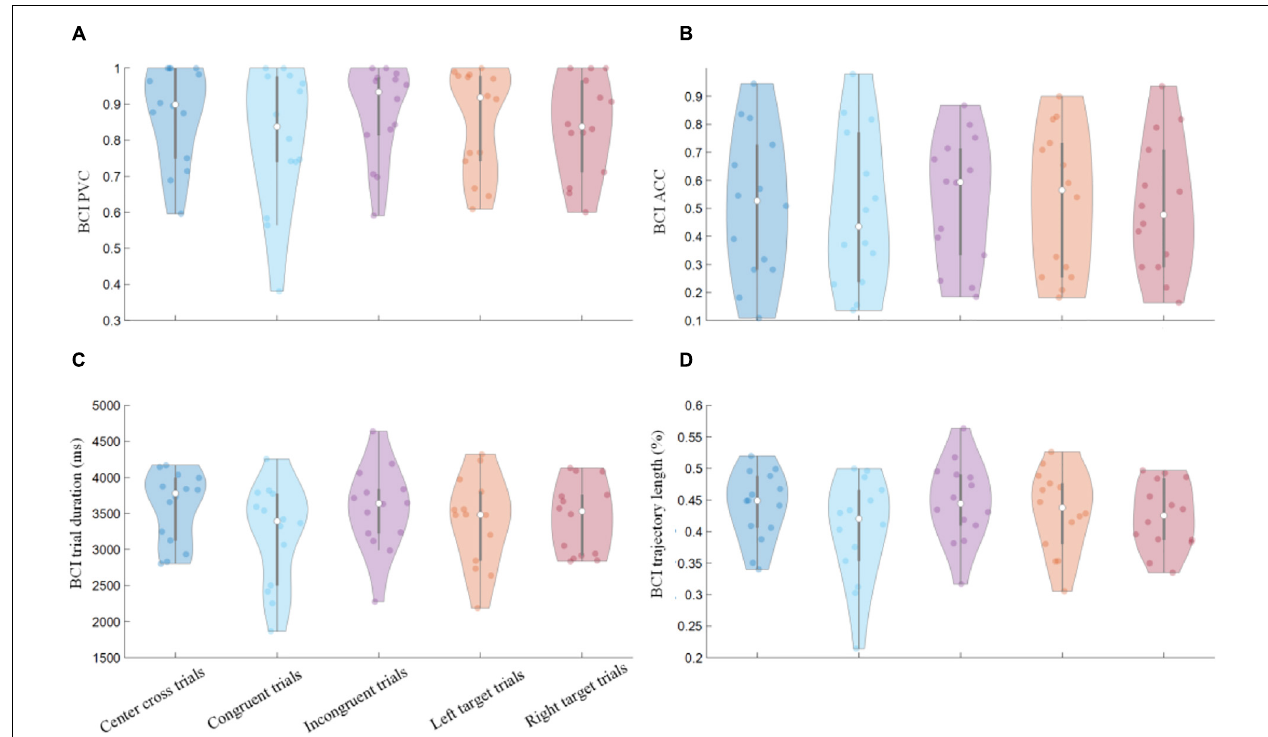
FIGURE 4 | BCI behavioral performances of separate control conditions. Group average results of (A) PVC, (B) ACC, (C) feedback duration of single trials, (D) trajectory length of single trials. The labels of x -axis for all of the four figures were the same, representing the categorization of trials in terms of the motor imagery tasks (left vs. right) and the congruency between the motor imagery task and the gaze fixation task. Violin plots: shaded areas represent kernel density estimate of the data, white circles represent the median, and gray bars represent the interquartile range.